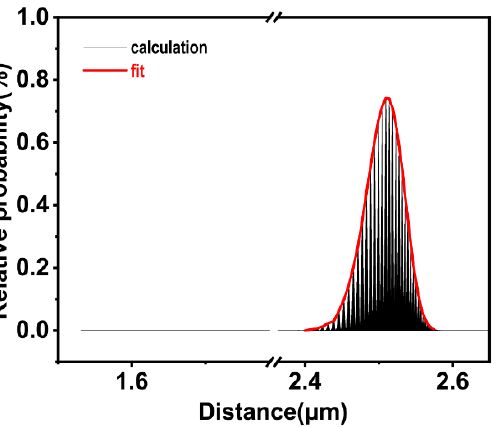
Figure 6. Probability distribution of the total penetration distances of the individual carbon black particles.